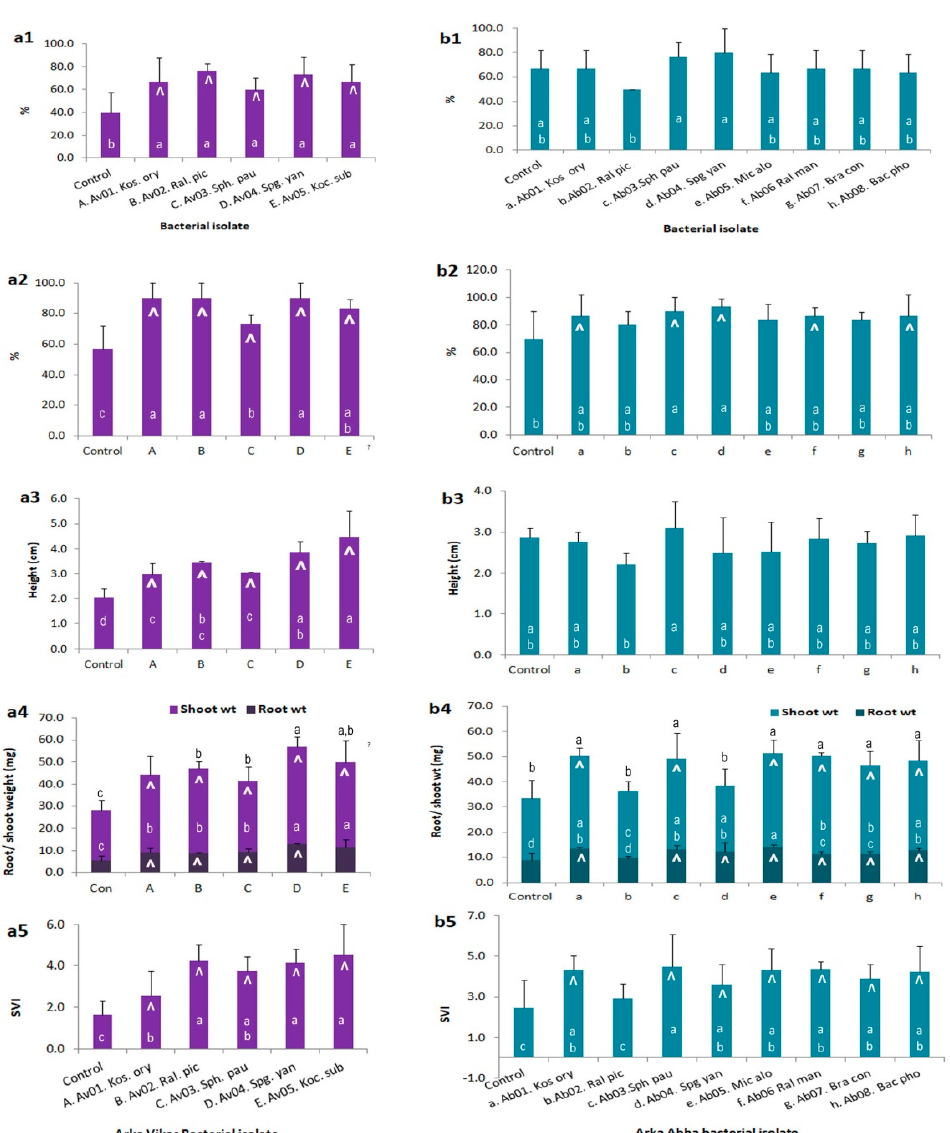
Figure 4. Assessing the endophyte-mediated host beneficial e ff ects through in vitro trials. ( a ) “Arka Vikas” seed inoculation with the “Av” isolates and ( b ) “Arka Abha” seed inoculation with the “Ab” isolates: Series 1, percent germination as on day 7; 2, seedling output after 2 weeks; 3, average seedling height; 4, root / shoot weight per seedling and 5, seedling vigor index (SVI). Upward arrow mark indicates ≥ 20% increase over un-inoculated control. Bars marked with varying letters represent treatments di ff ering significantly from each other.